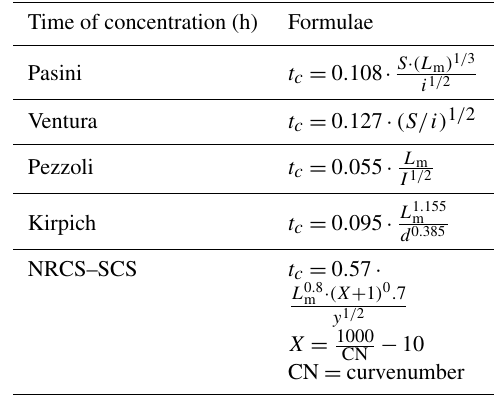
Figure 7. The flow chart for the prioritizing method: the spatial multicriteria analysis allows us to compare three sets of unhomo- geneous parameters to realize a classification of the catchments that can be used as a decision support system in risk mitigation planning. Table 3. Time of concentration formulae